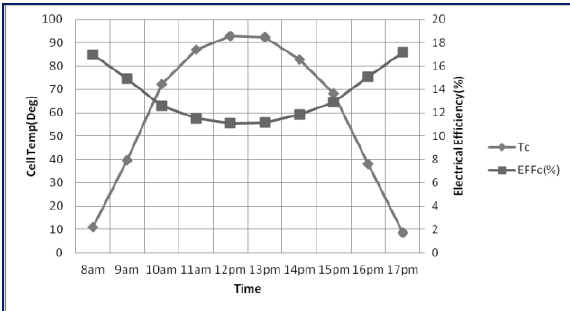
Figure 2. Comparison between cell temperature and electrical efficiency w.r.t